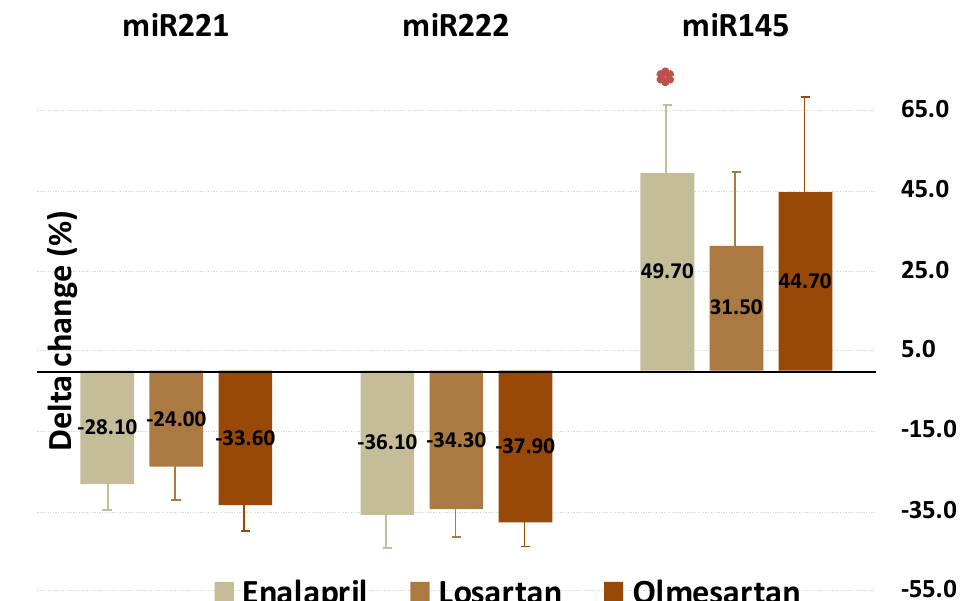
Figure 3. miR 221, 222 and 145 expression (upper panel) and change (%) from T0 to T1. Upper: n-fold expression with respect to basal healthy controls; ⤈ / ⤉ : decrease/increase, p < 0.001 vs. T0. Lower: delta change (%) by treatment with enal- april, losartan, olmesartan. * Best, vs. losartan.